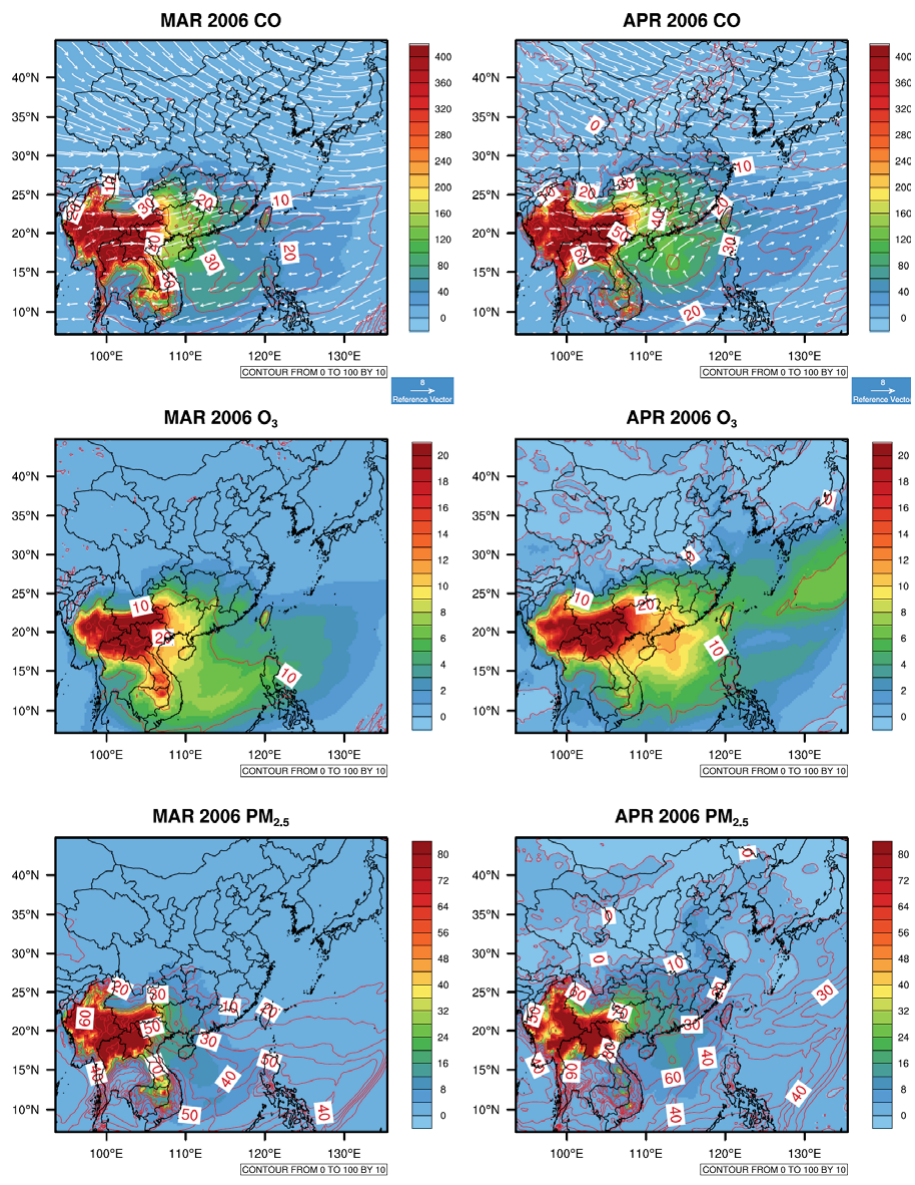
Fig. 7. Similar as Fig. 6 but monthly average impact during March and April in Figure 7. Similar as Figure 6 but monthly average impact during March and April in 2006